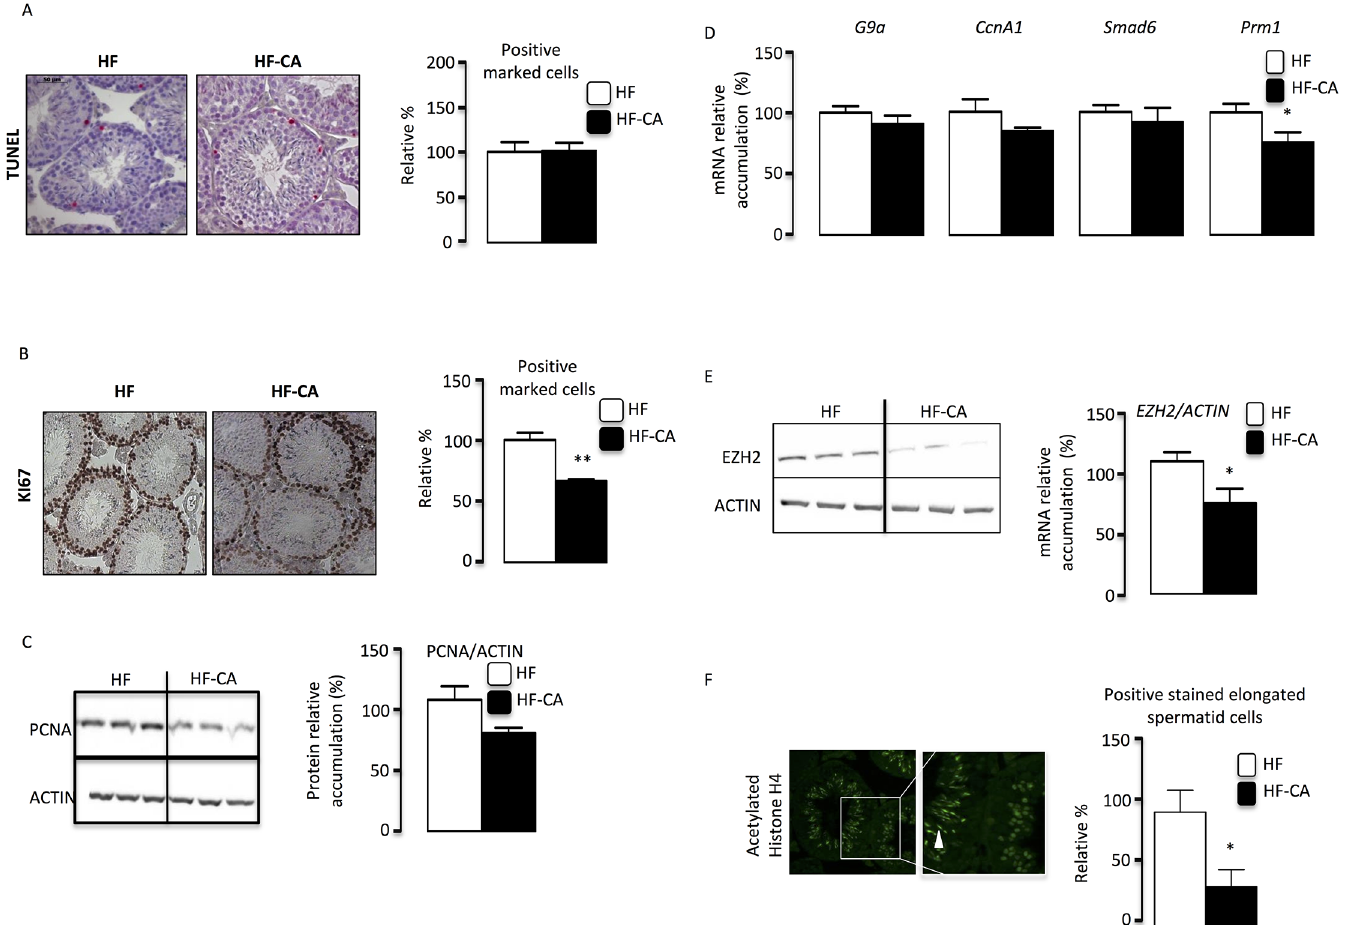
Fig 3. CA-supplementation diet induces increase of germ cell proliferation. (A) Apoptosis in mice exposed to HFD or HF-CA diets 4 months after the switch to HF-CA diet (n = 13 to 25 per group) analyzed by TUNEL staining. The arrow indicates apoptotic spermatocytes. The original magnification was X200. The number of TUNEL-positive cells per 100 seminiferous tubes. (B) Proliferation in mice exposed to HFD or HF-CA diets (n = per groups) analyzed by Ki – 67 staining. Representative micrographs of the testis exposed to HF and HF-CA diets. The original magnification was X100.Quantification of the number of Ki-67-positive cells per 100 seminiferous tubules after 2 and 4 months of HF and HF-CA diets (n = 4 – 5 per groups). (C) Immunoblot of PCNA and ACTIN on testicular protein extracts of HFD or HF-CA diet 4 months after the switch to HF-CA diet (n = 5 – 8 per groups). Quantification of PCNA/ACTIN ratio. HFD group was arbitrarily fixed at 100%. (D) Testicular mRNA expression of G9a , Cyclina1 (Ccna1) , Smad6 and Prm1 normalize to β -actin levels in whole testis of C57BL/6 mice fed HFD or HF-CA diets 4 months after the switch to HF-CA diet (n = 16 – 22 per groups).). (E) Immunoblot of EZH2 and ACTIN on testicular protein extracts of HF diets or HF-CA diets 4 months after the switch to HF-CA diet (n = 5 – 8 per groups). Quantification of EZH2/ACTIN ratio. HFD group was arbitrarily fixed at 100%. (F) Evaluation of post-meiotic elongated spermatids in mice exposed to HFD or HF-CA diets analyzed by acetylated histone H4 (H4ac) staining 4 months after the switch to HF-CA (Representative micrographs of the testis exposed to HF diet). The original magnification was X100.Quantification of the number of H4ac-positive cells (n = 4 – 5 per groups). Data represent mean ± SEM; Statistical analyses: * p < 0,05; ** p < 0,01 and *** p <